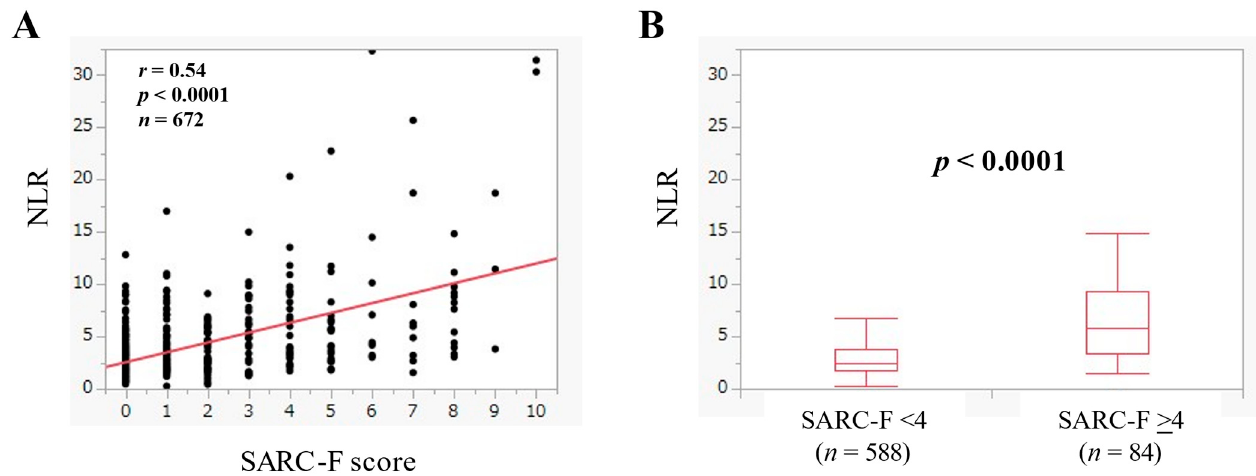
Figure 2. ( A ) The relevance in the NLR and the SARC-F score in all cases. ( B ) Comparison of NLR between SARC-F <4 ( n = 588) and ≥ 4 ( n = 84) in all cases.